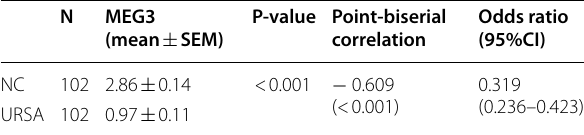
Table 1 The relationship between MEG3 and URSA N